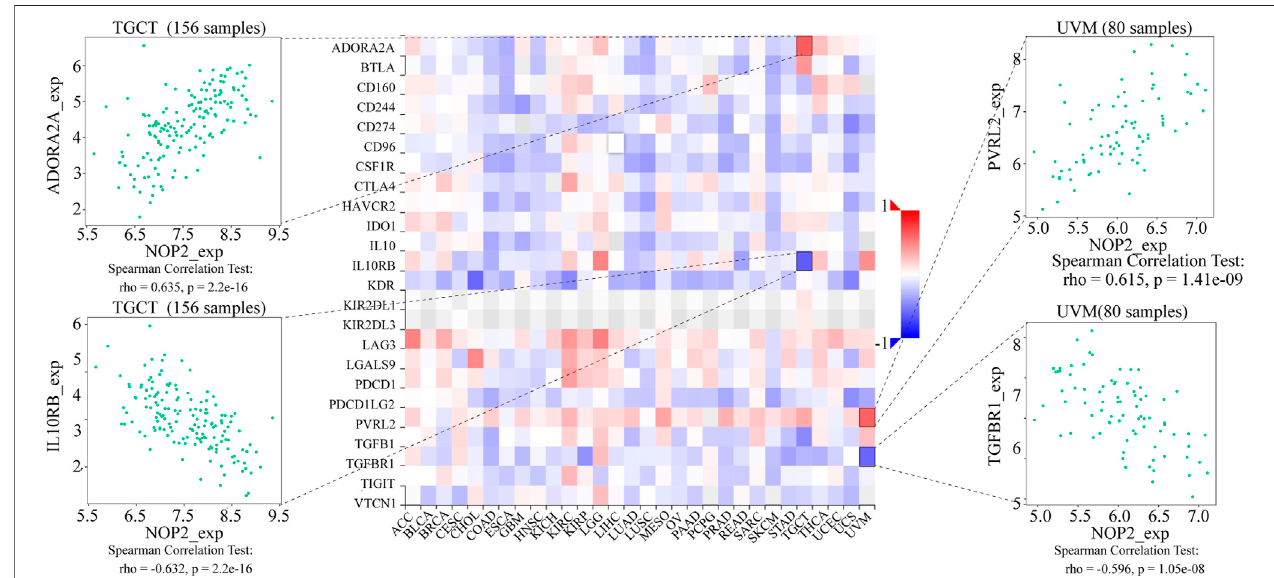
FIGURE 6 | Expression correlation between NOP2 expression and immune inhibitors. Red indicates positive correlation, whereas blue indicates negative correlation. The top four strongest associations are displayed via dot plots.